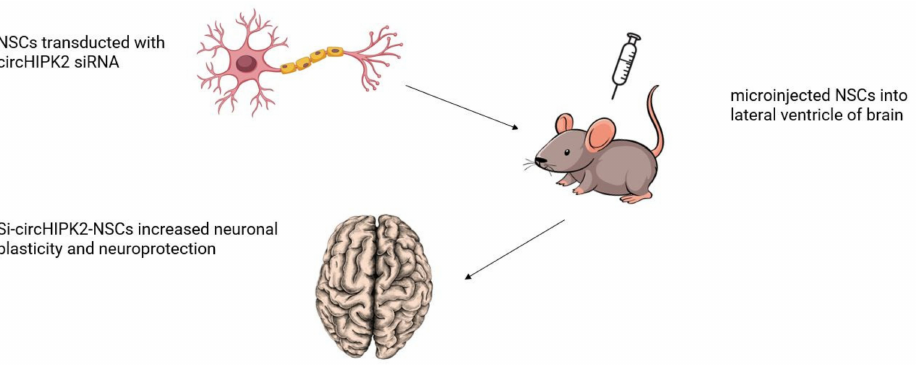
Figure 2. Role of circRNAs in neural stem cells differentiation and in the treatment of IS. NSCs were transducted with circHIPK2 siRNA and microinjected into lateral ventricle of brain at 7 days post tMCAO. Si-circHIPK2-NSCs regulates NSC differentiation and increased neuronal plasticity in the ischemic brain. NCS: neural stem cells; IS: ischemic stroke; circRNA: circular RNA; tMCAO: transient middle cerebral arterial occlusion; siRNA: small interfering RNA.